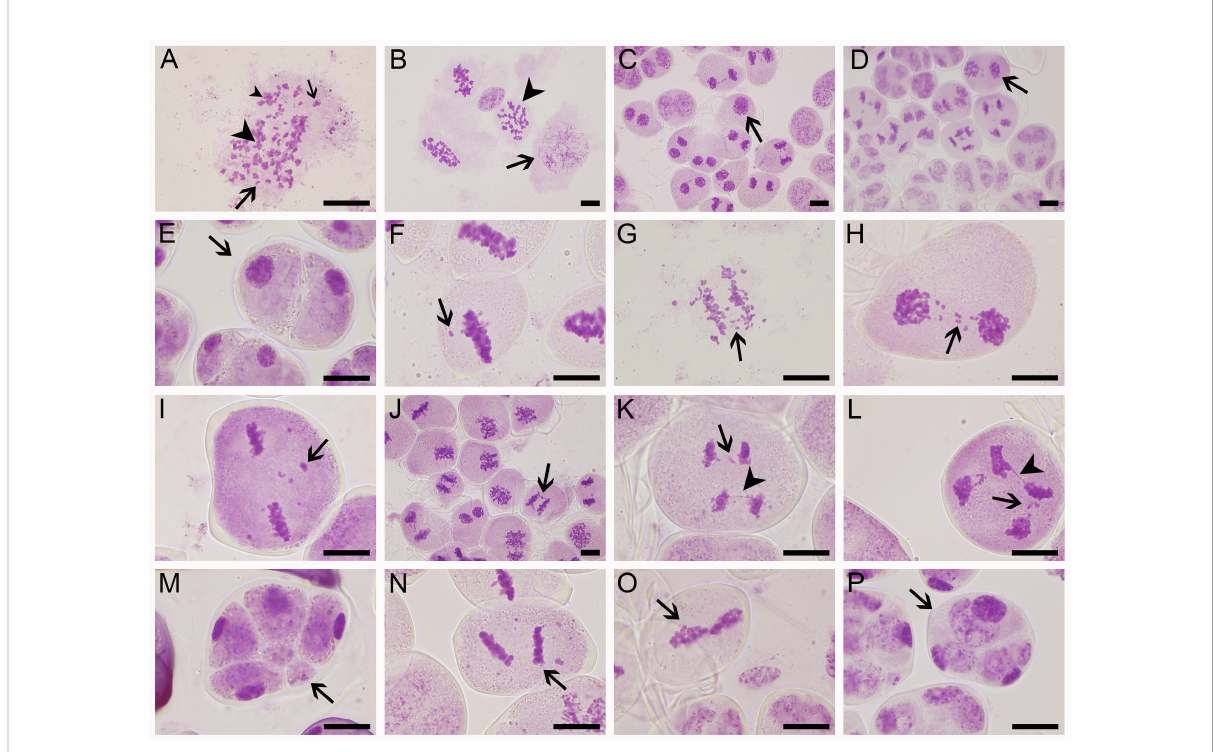
FIGURE 4 Meiotic abnormalities of sexual triploid ‘ Yuchan ’ . (A) Univalent (big arrow), bivalent (small arrow), trivalent (big arrowhead), and multivalent (small arrowhead) observed at diakinesis. (B) Metaphase I, microspore mother cells at pachyten (arrow) or diakinesis (arrowhead) stage were observed. (C) Telophase I: microsporocyte failed to carry out meiosis I (arrow). (D) Telophase II: microsporocyte that missed meiosis I but proceeded with normal meiosis II (arrow), which resulted in the formation of dyad (arrow) (E) . (F – I) Lagging chromosomes (arrow) at metaphase I, anaphase I, telophase I, and metaphase II. (J) Chromosome bridge (arrow) at anaphase (I) . (K) Lagging chromosomes (arrow) and a chromosome bridge (arrowhead) at anaphase II. (L) Lagging chromosomes (arrow) and a chromosome bridge (arrowhead) at telophase II. (M) Tetrad stage: indicating micronucleus (arrow). (N) Metaphase II: tripolar spindles (arrow). (O) Metaphase II: fused spindles (arrow). (P) Tetrad stage, indicating triad (arrow). Bar = 20 m